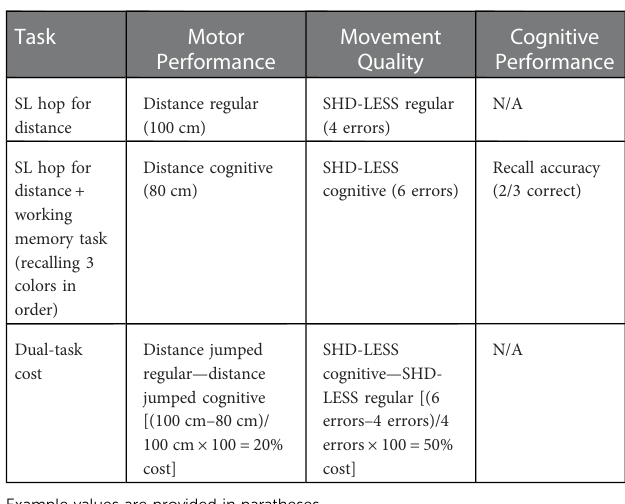
TABLE 2 Example calculation of dual-task cost of motor performance and movement